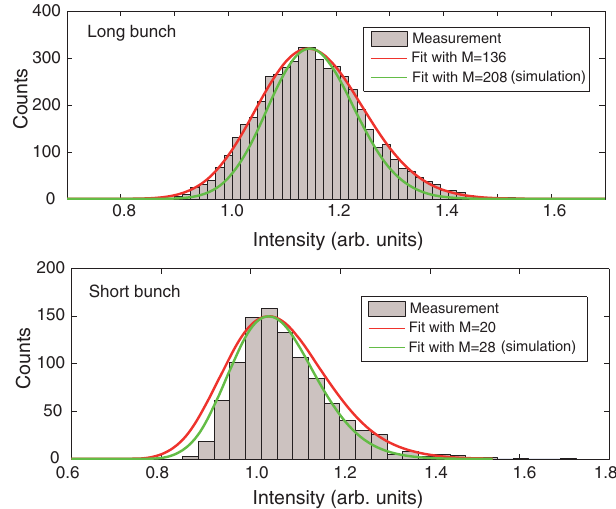
FIG. 69. Intensity distributions of SASE FEL pulses measured in the long-bunch (top) and the short-bunch configuration (bottom), shown as histograms. The curves overlaid represent fits to gamma distributions with the M parameter left free (red) and fixed to simulation results obtained for equivalent beam conditions.